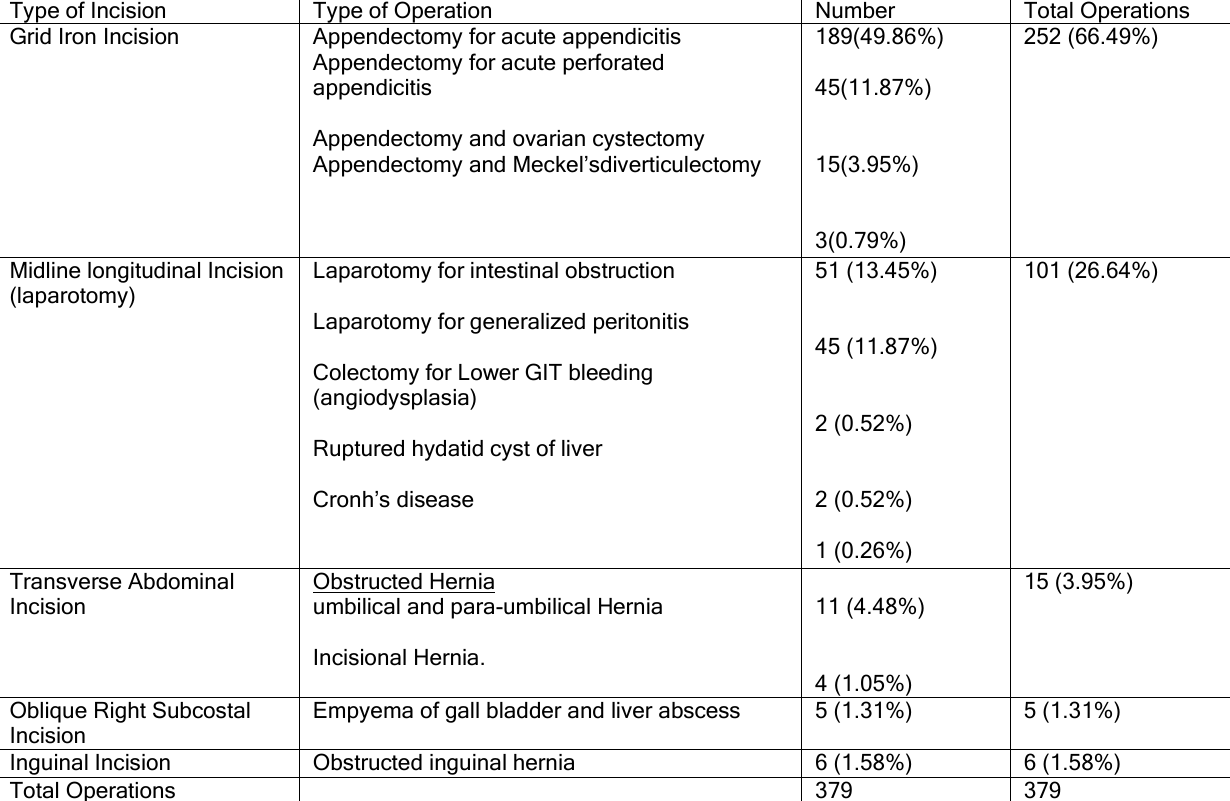
Table (1): Types of operations and incisions done for Group B patients.